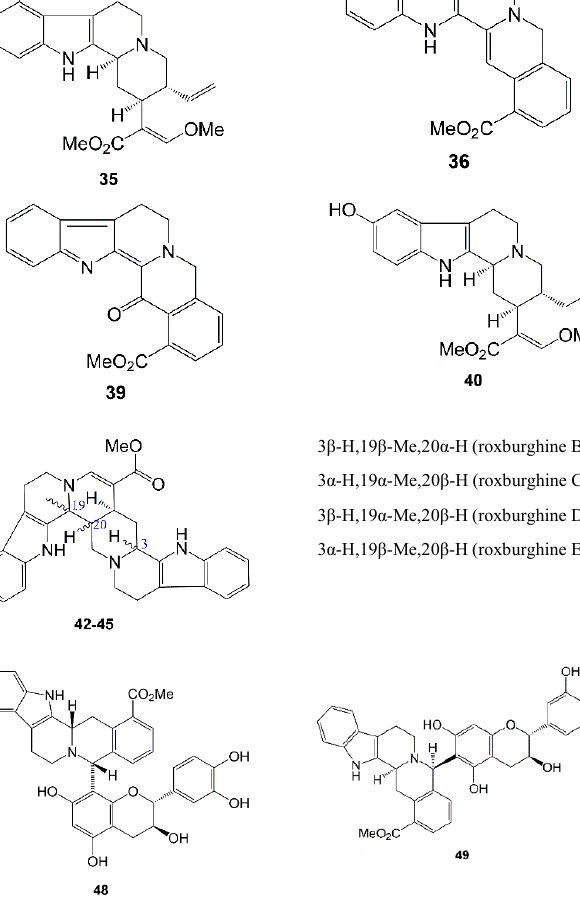
Table 1. Compounds identified from Uncaria gambir Roxb.